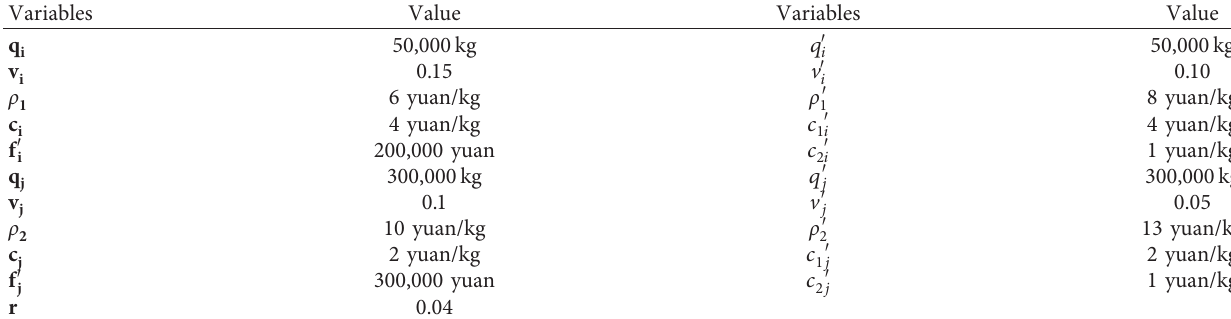
Table 1: Data used to simulate the benefits change with variables of different